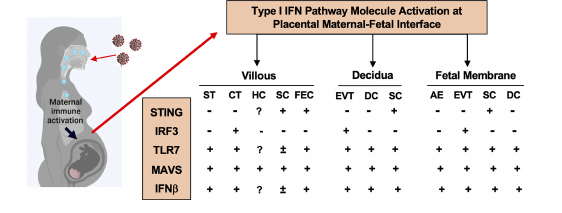
FIGURE 5 A summary of type I IFN pathway molecule activation in different cell types at the maternal-fetal interface in placentas from women infected with COVID-19 in pregnancy. ST, Syncytiotrophoblasts; CT, cytotrophoblasts; HC, Hofbauer cells; SC, stromal cells; FEC, fetal endothelial cells; DC, decidual cells; AE, amnion epithelial cells; EVT, extra-villous trophoblasts,